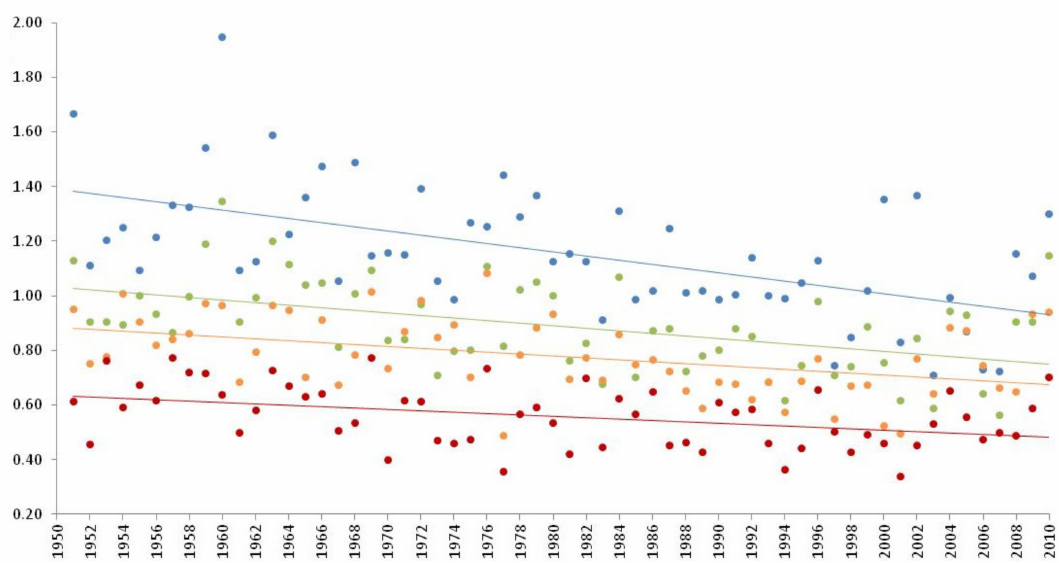
Figure 2. Long-term trends (1950–2010) in the climate aridity index (annual average, y-axis) by year and geographical division in Italy (blue = Northern Italy; green = Central Italy; orange = Southern Italy; red = Sicily and Sardinia). The colored lines indicate a linear trend fitting the aridity data in each